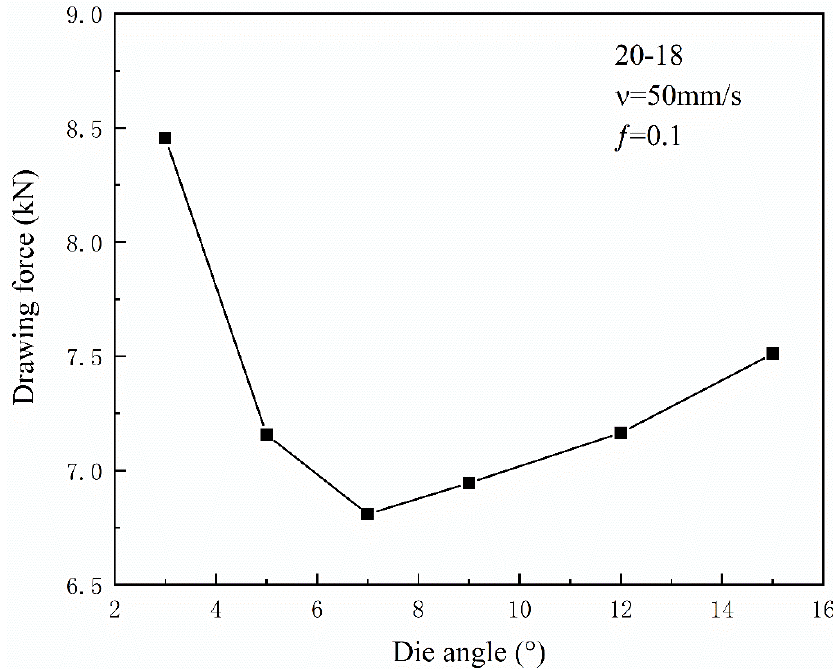
Figure 16. The relationship curve between drawing force and drawing die angle.